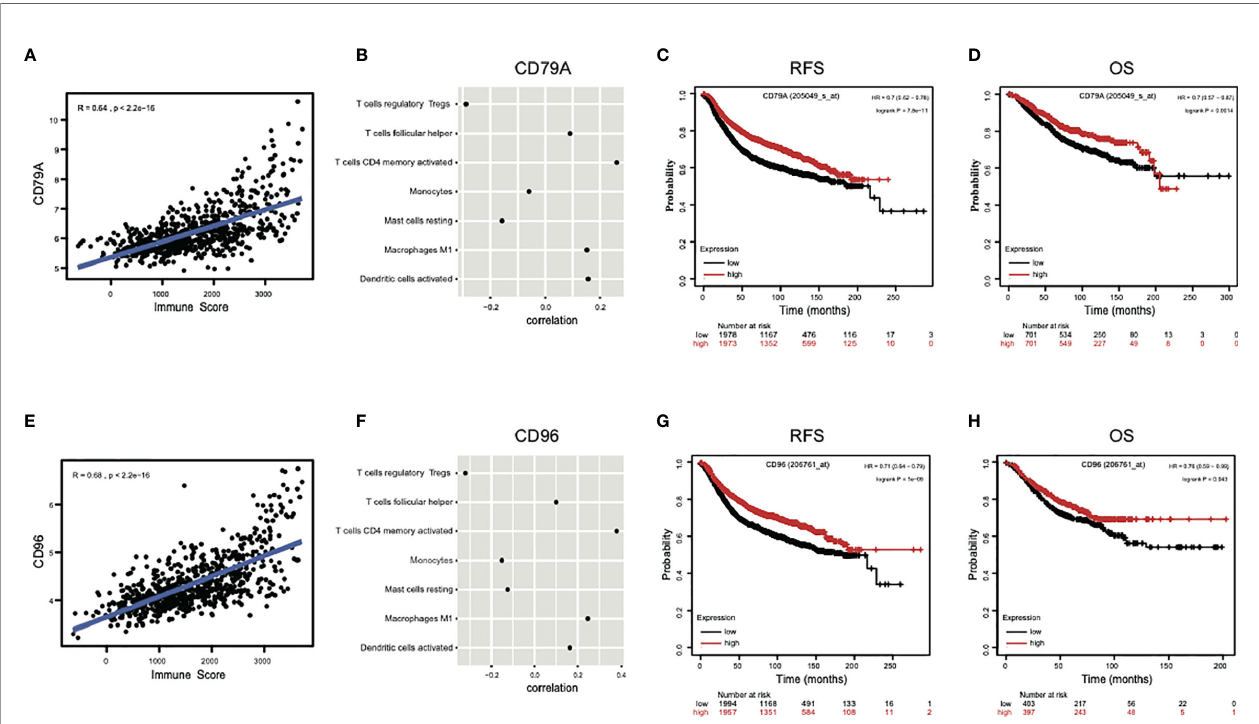
FIGURE 6 | The genes contained in the signature re fl ect immune response and prognosis. (A, E) The expressions of two genes with highest coef fi cient, CD79A and CD96, presented strong positive correlations with immune scores. (B, F) The expressions of CD79A and CD96 also showed signi fi cant positive correlations with immune in fi ltrations of “ T cells CD4 memory activated, ” “ T cells follicular helper, ” “ Macrophages M1, ” “ Dendritic cells activated, ” and signi fi cant negative correlations with “ T cells regulatory, ” “ Monocytes, ” and “ Mast cells resting. ” (C, D, G, H) The increased expressions of CD79A and CD96 were signi fi cantly associated with higher RFS, OS in breast cancer by Kapan-Meier survival analysis. RFS, relapse-free survival; OS, overall survival; HR, hazard